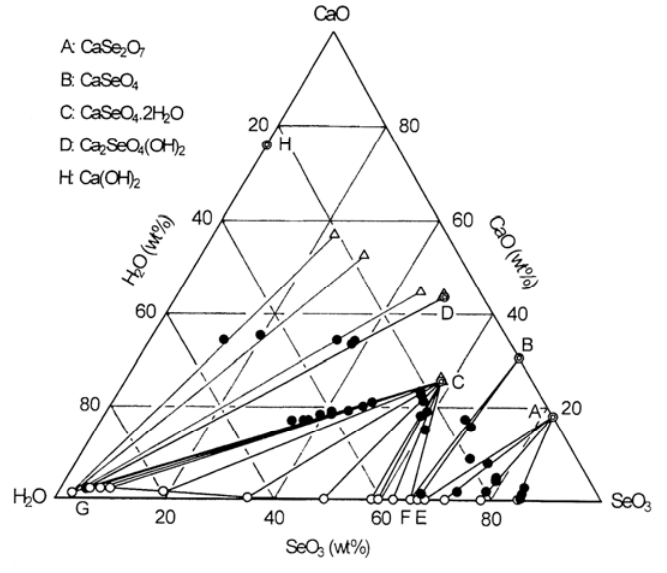
-H O system at 25 3 2